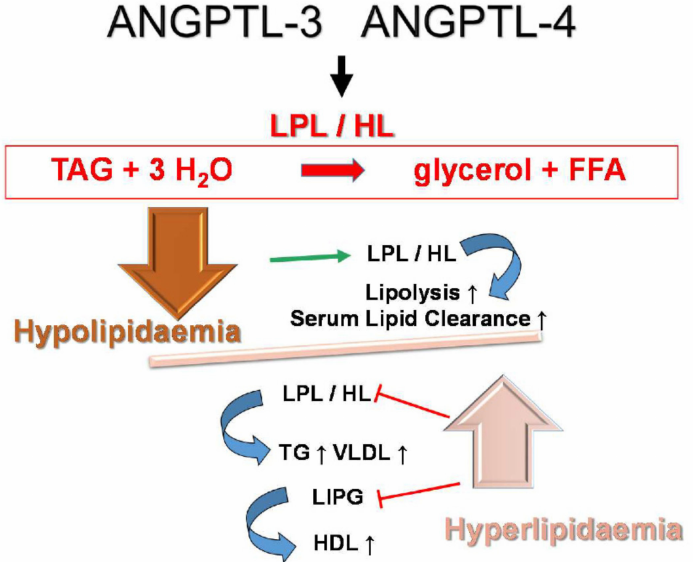
Figure 1. The role of angiopoietin-like proteins (ANGPTLs) in lipid metabolism. ANGPTL-3 and ANGPTL-4 regulate serum lipid levels via inhibition of the enzymatic activities of lipoprotein lipase (LPL), hepatic lipase (HL) and endothelial lipase (LIPG) (LIPG is regulated by ANGPTL-3 only). Lipases hydrolyse the triacylglycerols (TAG) of lipoproteins and chylomicrons into non-esterified free fatty acids (FFA) and monoacylglycerols. Upon silencing of ANGPTLs, loss of lipase regulation results in enhanced lipolysis and increased clearance of serum lipids by the liver and other tissues [43], eventually leading to hypolipidaemia. On the contrary, overexpression of ANGPTLs blocks lipases, thereby increasing circulating lipoproteins and resulting in hyperlipidaemia